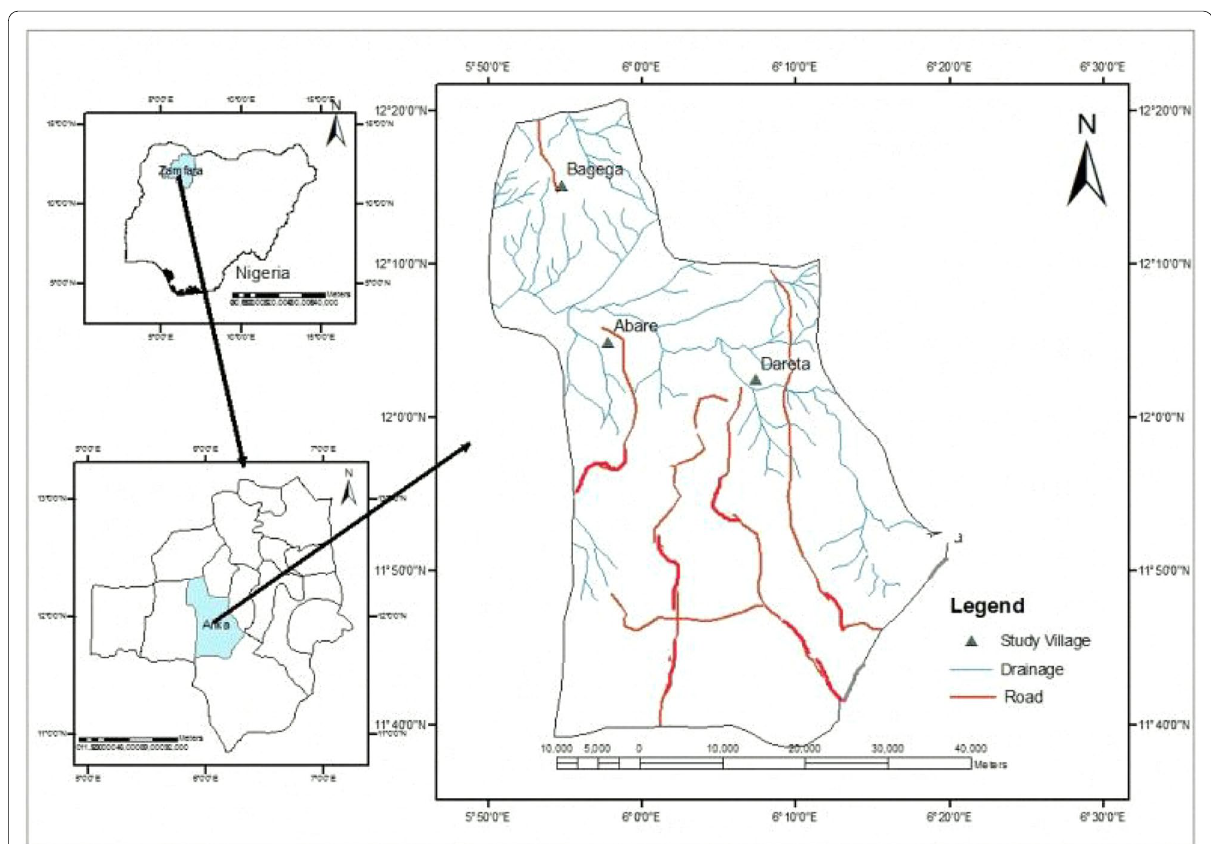
Fig. 1 Location of the study sites from Anka local government, Zamfara state,